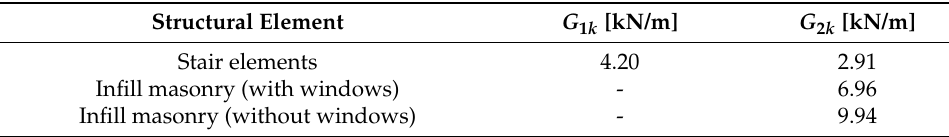
Table 4. Characteristic values of linearly distributed loads.